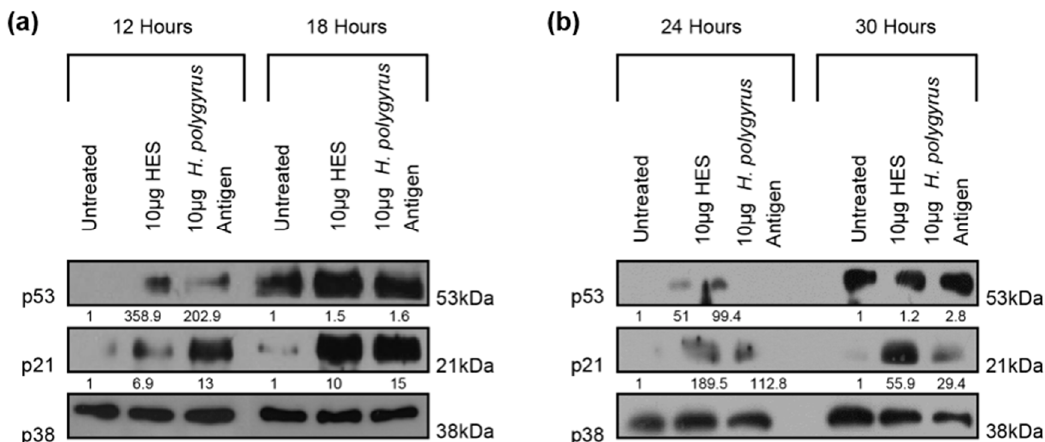
Figure 3. H. polygyrus -derived antigens increase the expression of colorectal cancer (CRC) cell-cycle arrest proteins p53 and p21. Western blot analyses of p53, p21, and p38 (loading control) were performed following exposure of ( a ) CT26.WT cells for 12- and 18-h and ( b ) HCT116 cells for 24- and 30-h to 10 µ g HES or 10 µ g H. polygyrus antigen. Densitometry readings were obtained using ImageJ in